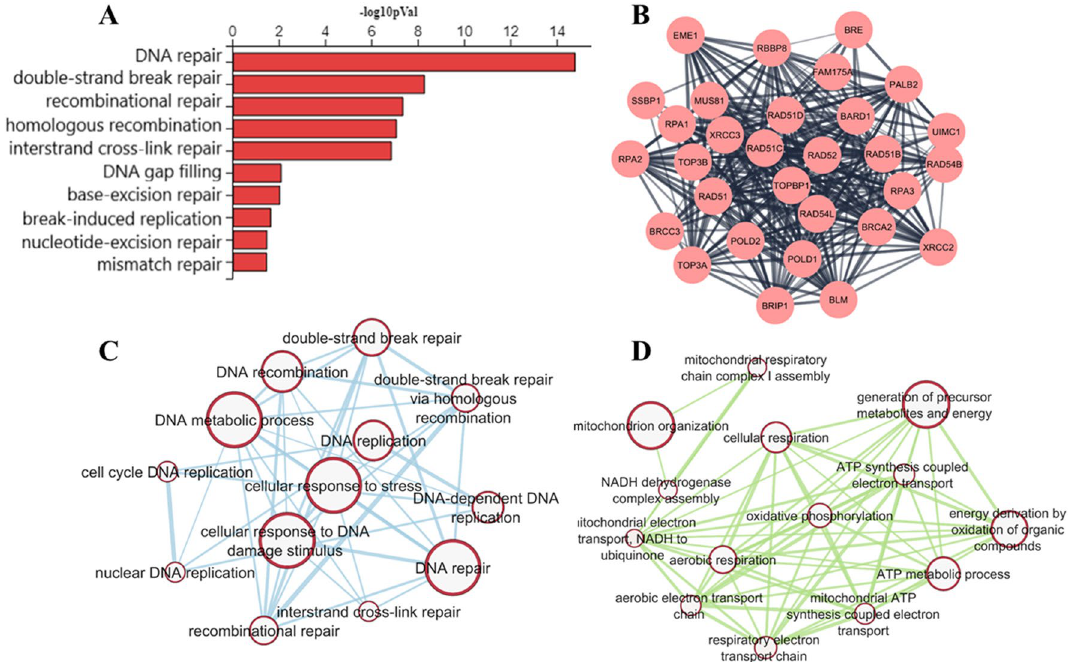
Figure 1. ( A ) Enriched biological processes related to DNA repair pathways including homologous recombination (GO:0000725), base excision repair (GO:0006284), nucleotide excision repair (GO:0006289) and mismatch repair (GO:0006298). ( B ) A protein interaction network generated using STRING of genes differentially expressed in the Homologous recombination pathway (KEGG: 03440) 39 . ( C ) Enrichment